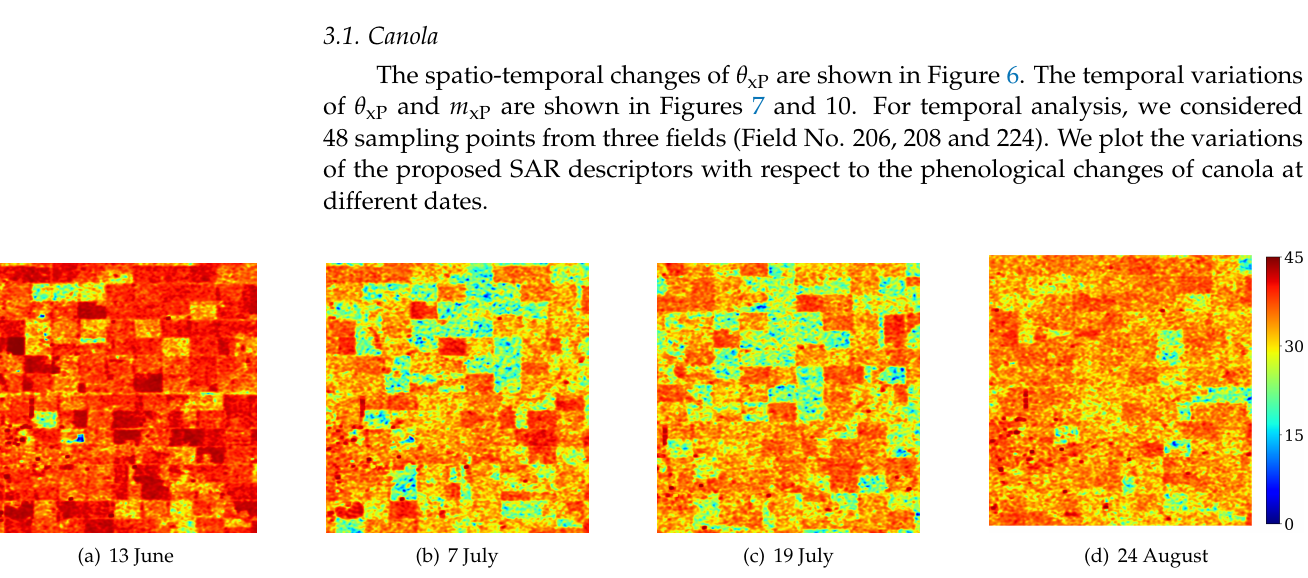
Figure 6. Temporal variation of θ xP over the study area. The dates are ( a ) 13 June, ( b ) 7 July, ( c ) 19 July and ( d ) 24 August.